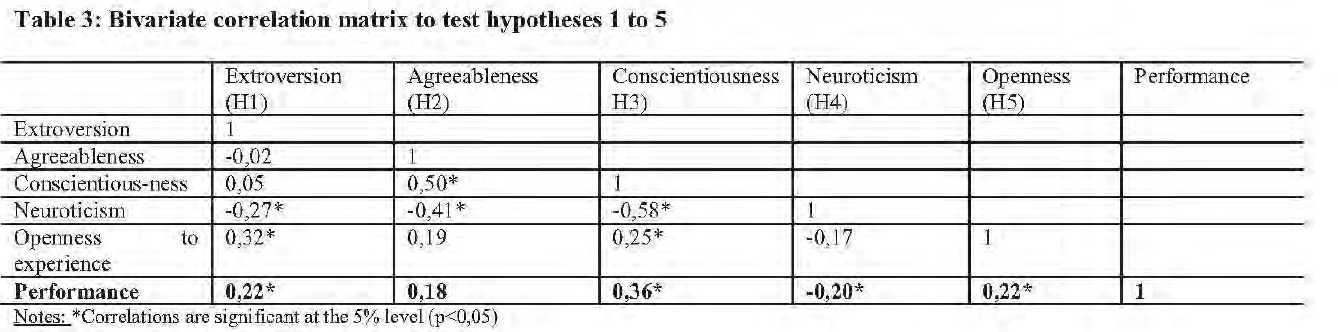
Table 3: Bivariate correlation matrix to test hypotheses 1 to